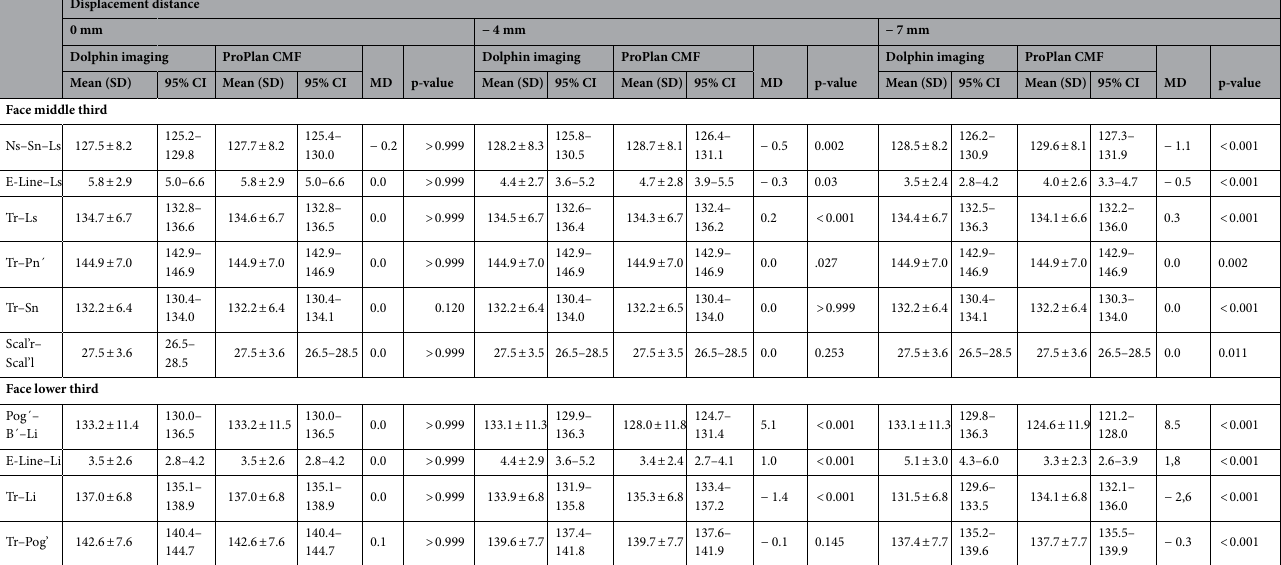
Table 7. Mean values, SDs and 95% confidence intervals of the angular and linear changes in the middle and lower third of the face after mandibular surgery simulation with the corresponding p values of the comparison between the outcome of the surgical planning program Dolphin and ProPlan depending on the different displacement distances for mandibular setback. SD standard deviation, CI confidence interval, MD mean